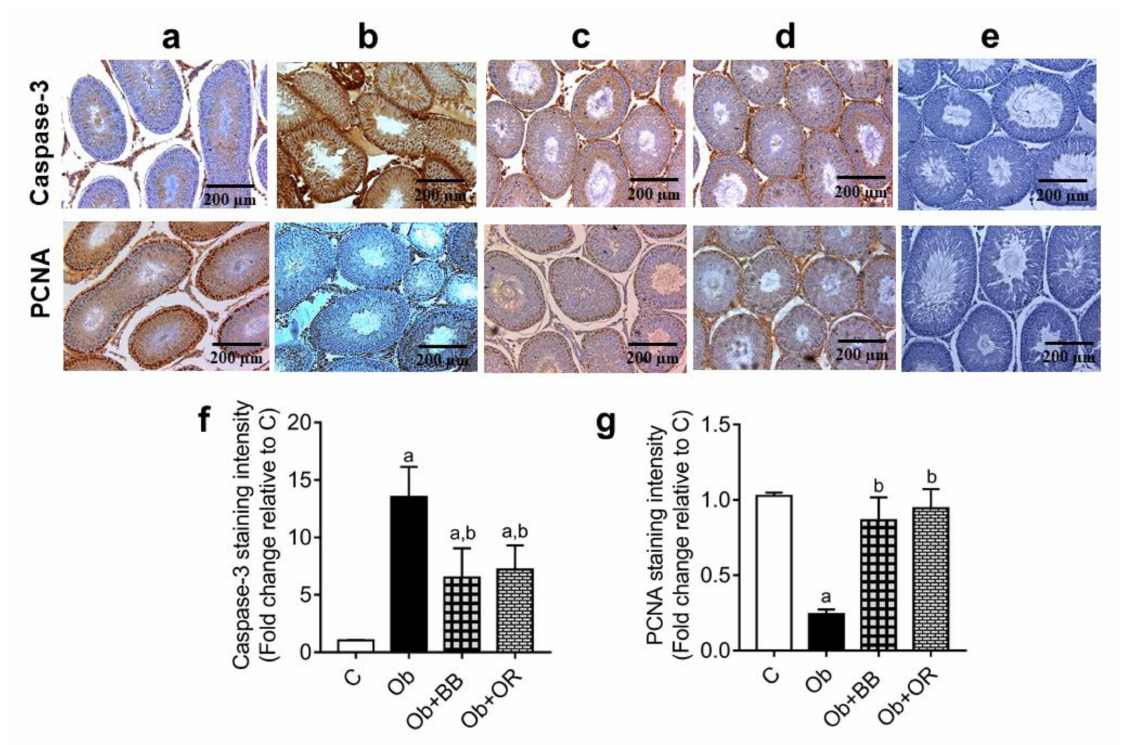
Figure 6. Effects of bee bread on immunoexpression of cleaved caspase-3 protein and prolifer- ating cell nuclear antigen (PCNA) in the testes of obese rats. For each protein, C, Ob, Ob + BB, and Ob + OR groups are represented by ( a – d ), respectively, while ( e ) represents the negative control (PBS). Staining using immunohistochemistry protocol showed seminiferous tubules with increased cleaved caspase-3 and decreased PCNA levels in Ob group compared to C, Ob + BB, and Ob + OR groups (magnification = × 100, scale bar = 200 µ m). Quantitative data are shown in ( f ) Caspase-3 staining intensity, and ( g ) PCNA-positive germ cells. Values are mean ± SD, n = 6. a p < 0.05 vs. C, b p < 0.05 vs. Ob (one-way ANOVA followed by Tukey’s post-hoc